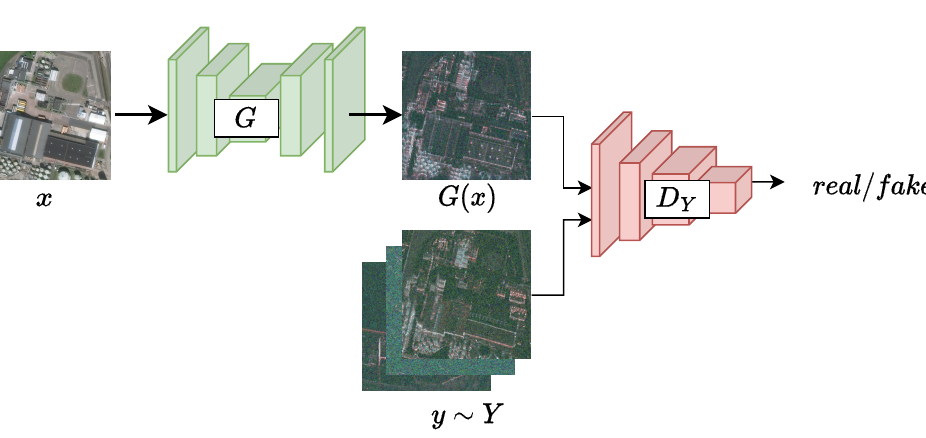
Figure 1. Training framework of GAN. The discriminator D Y is optimized to approximate the possibility that the incoming image is from the real SAR domain rather than the generator G . On the other hand, the generator G is optimized to maximize the possibility that the discriminator D Y makes wrong predictions on the fake SAR image G ( x ) , which is conditioned on a real EO image x